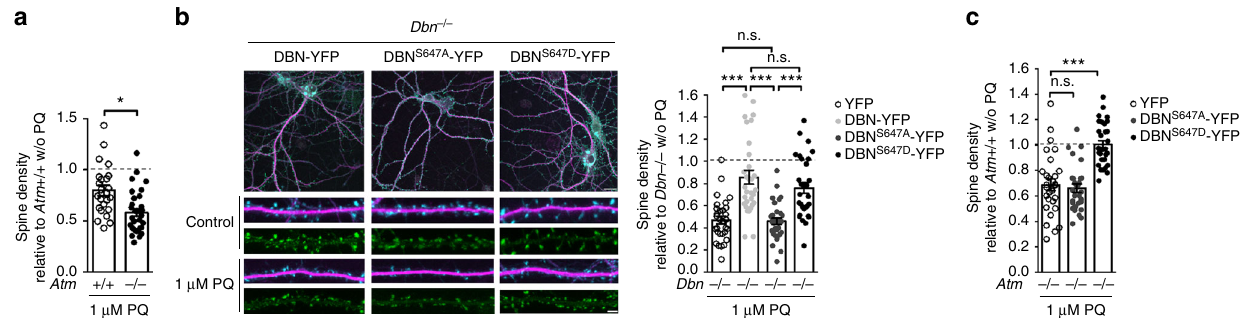
Fig. 6 DBN S647D , but not DBN S647A , rescues the loss of DBN or ATM. a Spine density analysis of Atm + / + or Atm − / − hippocampal neurons treated with PQ for 24 h. ATM + / + : N = 3, n = 24; ATM − / − : N = 3, n = 31. b Spine density analysis of Dbn − / − hippocampal neurons infected with YFP constructs in the presence of PQ. Left: representative overlay of a neuron expressing DBN-YFP (green) labelled with MAP2 (magenta) and Phalloidin (F-actin, cyan). Upper images: scale bar 20 µ m. Lower images: scale bar 3 µ m. Right: bar graph presents spine density relative to DBN knockout controls. N = 3. YFP: n = 30, DBN-YFP: n = 31, DBN S647A -YFP: n = 32, DBN S647D -YFP: n = 30. c Spine density analysis of ATM − / − hippocampal neurons infected with